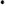
ACh reduces optical stimulation-evoked EPSC peak amplitude, but does not change STP. (A) Representative traces of paired pulse optical stimulation (arrows) evoked EPSCs at interstimulus intervals of 0.05, 0.075, 0.125 and 0.25 s (corresponding to stimulation frequencies of 20, 13.3, 8 and 4 Hz in ACSF (control), during bath application of ACh (50 μM), and after washout. (B) Representative traces of paired pulse optical stimulation evoked EPSCs in the presence of AgTX (50 nM) and AgTx (50 nM) plus ACh (50 μM). (C) Population data showing EPSC amplitude as a percentage of ACSF amplitude. (D) Population data (n = 6) showing PPR under control (open circle), in the presence of ACh (red circle), following ACh washout (star) and in the presence of AgTX (triangle) and AgTX/ACh (open triangle). The control EPSCs were similar, but they might be different from that of the test EPSC peak amplitude. The rise and the decay time were the same. For instance, at interval of 0.125 s/8 Hz, control and test rise time, decay time and peak amplitude was 1.72 ± 0.27 and 1.67 ± 0.33 ms, 10.22 ± 1.47 and 10.07 ± 1.58 ms, 96.84 ± 13.95 and 136.78 ± 16.23 pA in ACSF, and 1.61 ± 0.38 and 1.65 ± 0.43 ms, 9.36 ± 1.66 and 9.43 ± 1.72 ms, 45.42 ± 5.34 and 63.77 ± 5.94 pA in ACh. Statistical significance P < 0.01 vs. ACh; P < 0.01 vs. Washout; *P < 0.01 vs. AgTx.